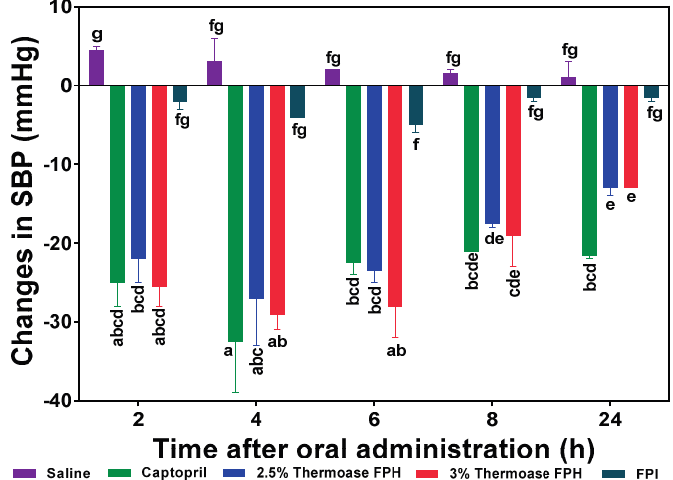
Figure 5. Effects of 2.5% and 3% enzymatic flaxseed protein hydrolysate (FPH), and flaxseed protein isolate (FPI) samples on systolic blood pressure (SBP) of spontaneously hypertensive rats (SHR) after oral gavage. Rats were administered with FPH and FPI using a dose of 200 mg protein/kg rat body weight (BW) while the positive control, captopril was given at 10 mg/kg body weight. Saline was used as negative control. Bars with different letters have mean SBP values that are significantly ( p < 0.05) different.